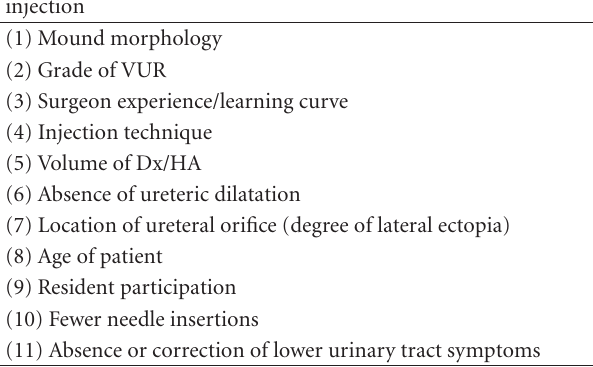
Table 1: Reported variables associated with VUR correction using